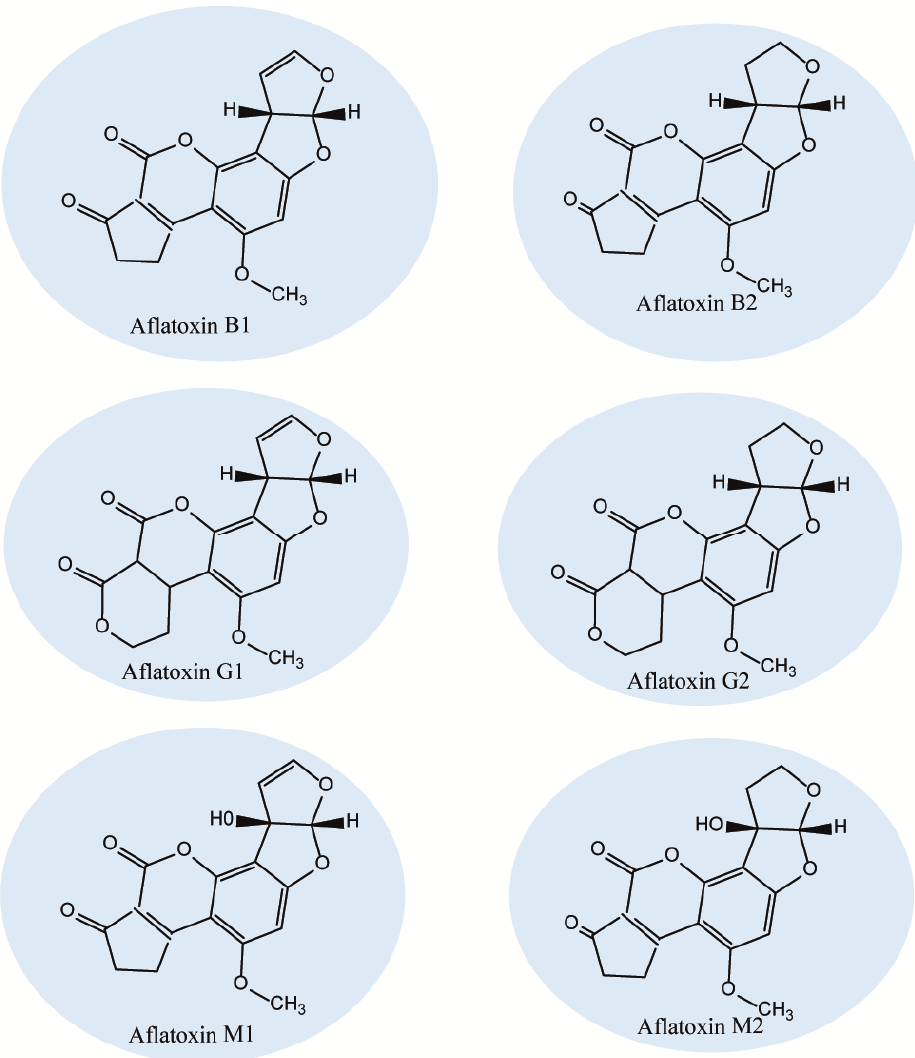
Figure 2. Chemical structures of group 1 carcinogenic aflatoxins.